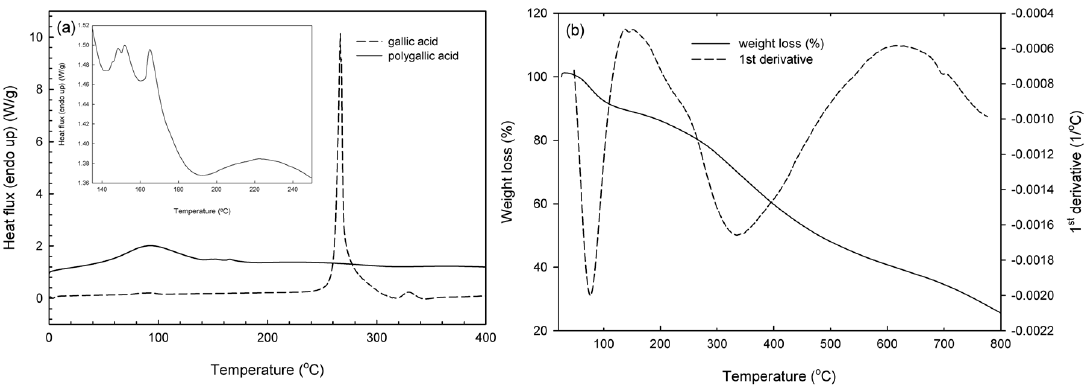
Figure 7 . Thermal analysis curves ( a ) DSC and ( b ) TGA of enzymatically synthesized poly(gallic acid).